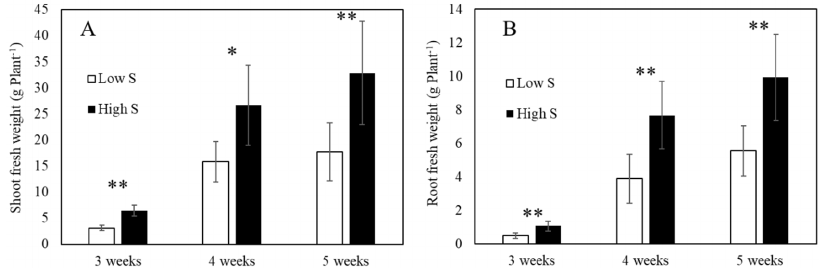
Figure 2. Effects of high sulfur treatment on the leaf ( A ) and root ( B ) fresh weight of lettuce. The data indicate the means ± S.E. (n = 5). Asterisks indicate significant differences. * p value < 0.05; ** p value < 0.01.